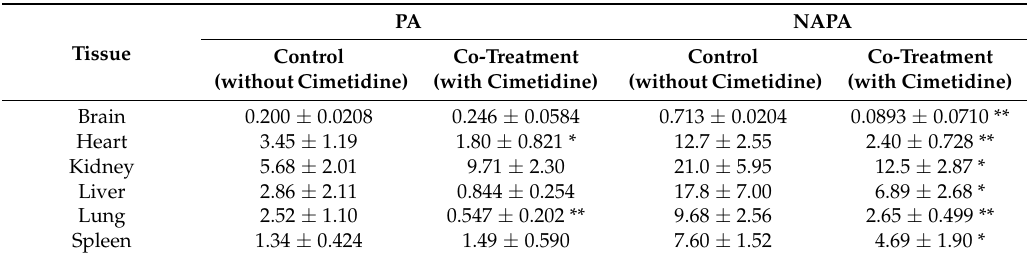
Table 5. Tissue-to-plasma concentration ratio at steady state ( K p , ss ) of PA and NAPA for 6 major tissues ( n = 5 for each group).